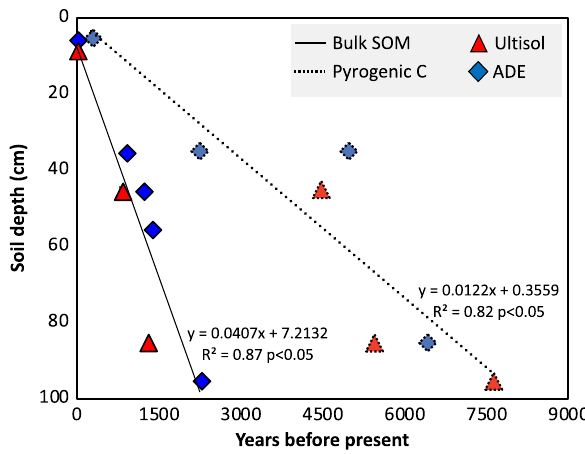
Fig. 5 Age-depth model for bulk soil organic matter (solid line) and pyrogenic carbon (dashed line). Each data point represents one calibrated 14 C date expressed in years before present. Propagated analytical uncertainties of the standard errors associated with each individual 14 C measurement ranged between 15 and 80 calibrated years and are smaller than symbols.